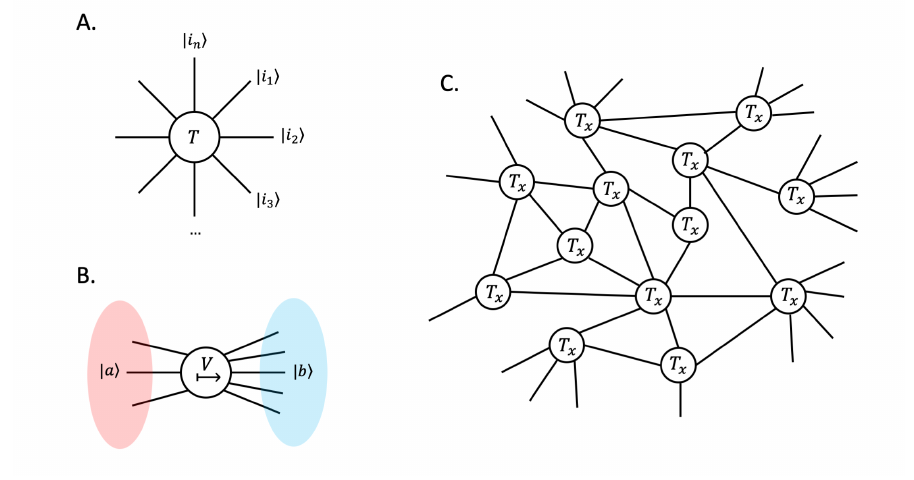
Figure 2 . A) Graphical representation of tensor from eq. (2.1). B) Graphical representation of reshaping a tensor into a mapping from eq. (2.3). C) Example of contracting tensors together to form a tensor